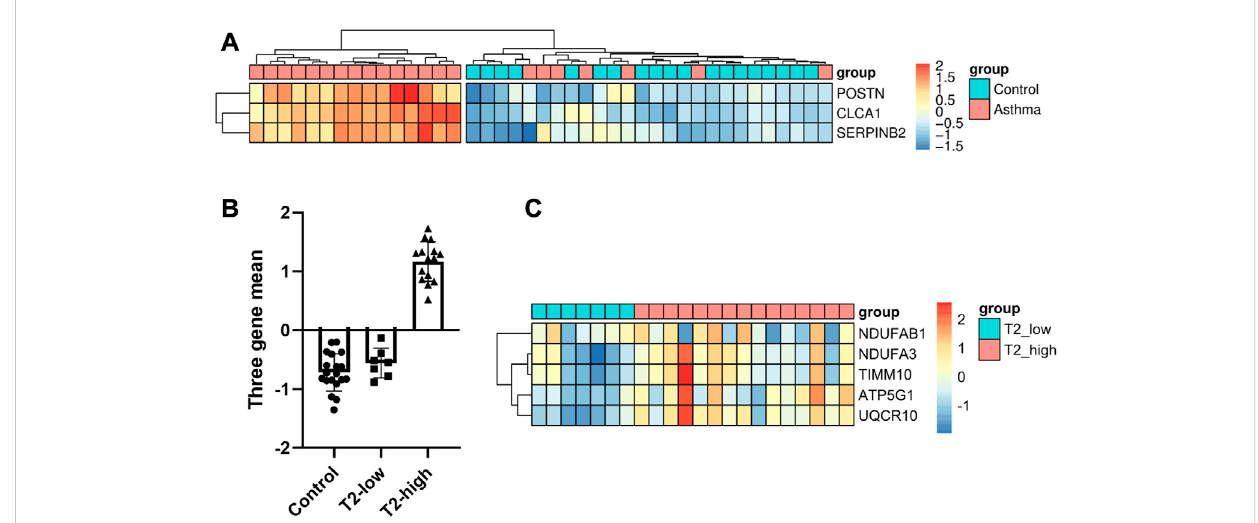
FIGURE 7 Identi fi cation of DEGs between T2-low and T2-high asthma in clinical samples. (A) Heatmap showing unsupervised hierarchical clustering of POSTN, SERPINB2, and CLCA1 expression levels in bronchial epithelium (red represents a high expression level, and blue represents a low expression level); (B) Dot plot of three-gene mean of POSTN, SERPINB2, and CLCA1 expression levels in control, T2-low and T2-high asthma; (C) Heat map of the fi ve hub gene levels (red represents a high expression level, and blue represents a low expression level).